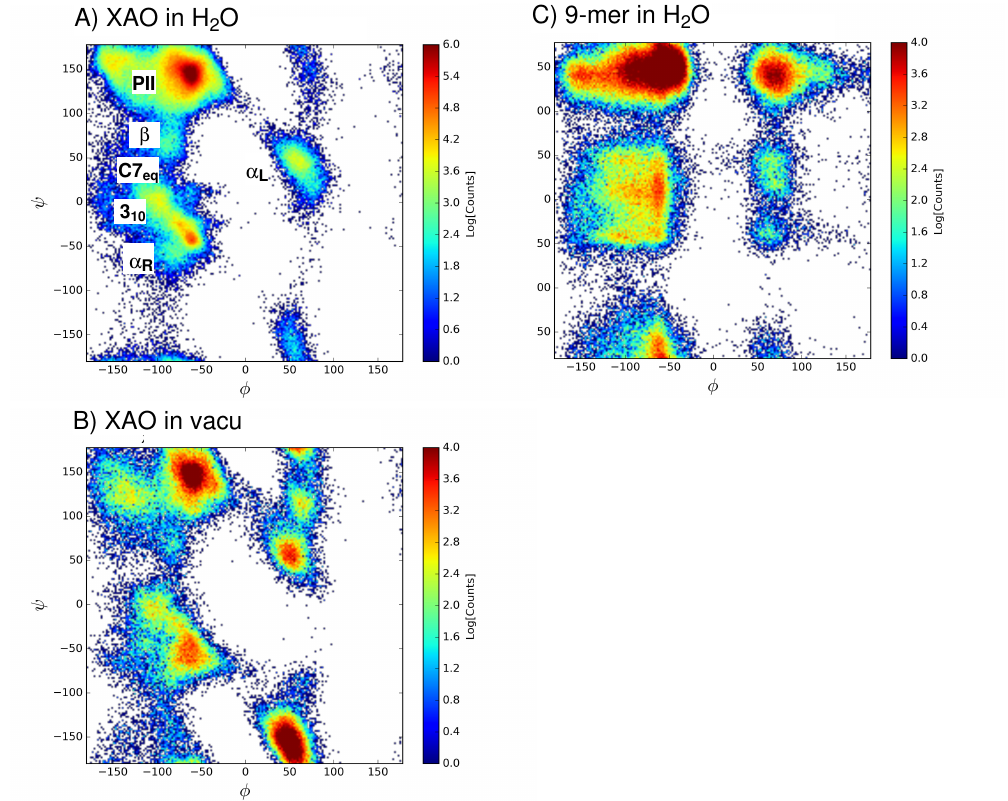
Figure 3. The distribution of Φ - Ψ angles sampled by ( A ) XAO in water (production data collected from 900 ns MD); ( B ) XAO in vacuo (production data collected from 200 ns MD); and ( C ) the 9-mer in water (production data collected from 200 ns data) are